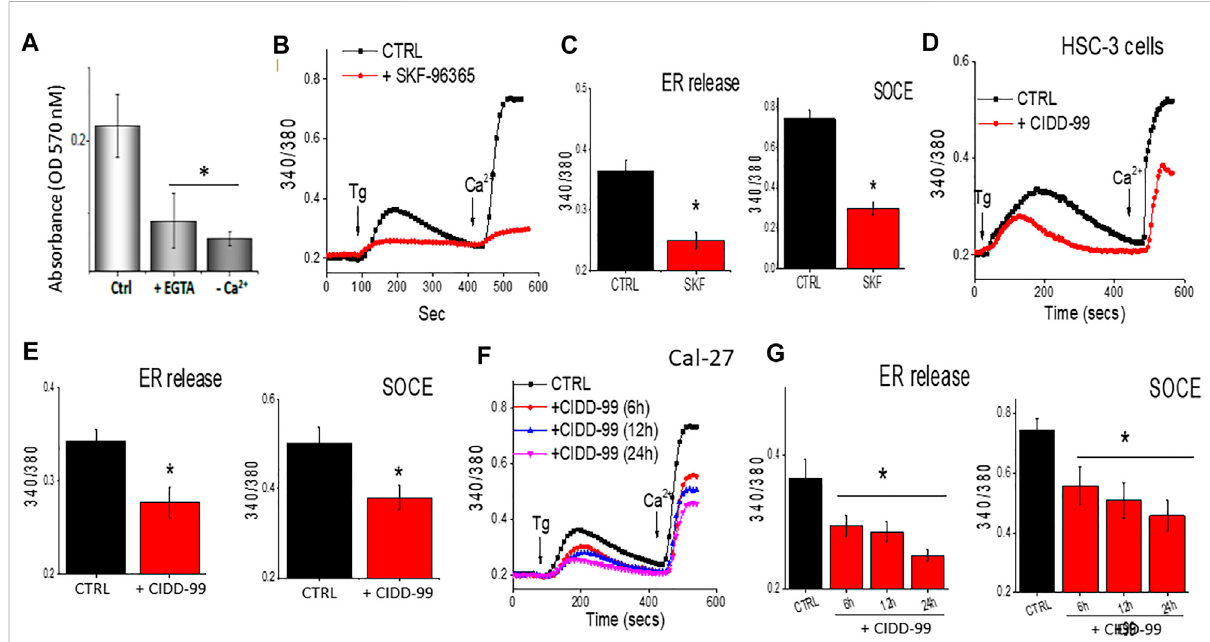
FIGURE 2 CIDD-99 disruptscalciumhomeostasisinOSCCcelllinesandreducesabilitytoactivateTRPC1. (A) Cal-27cellsweretreatedwithEGTA(5 mM) ormediumdevoidofexternalcalciumforaperiodof24 handpercentsurvivalwasmeasuredbyMTTassay.Signi fi cancewasdeterminedusingone- way ANOVA and *indicates p = 0.05, n= 3with 4independent replicates. (B) Cal-27 cells weretreated with SKF-96365 (10 µM)orcontrol untreated cells for 24 h, and fura 2 analog plots (340/380 ratio) were measured in the presence of 2 μ M Thapsigargin. (C) Quanti fi cation of fl uorescence ratio(peakvalue)from60 – 80individualcellsisshownasbargraph.*Indicatesdatathatissigni fi cantlydifferentfromcontrolvehicletreatedcells( p < 0.05 using one-way ANOVA). (D) HSC-3 cells were treated with CIDD-99 (10 μ M) with different hours and fura 2 analog plots (340/380 ratio)